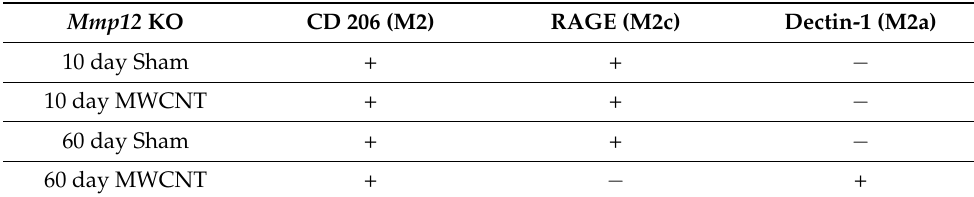
Table 1. Summary of Macrophage Specific Markers.